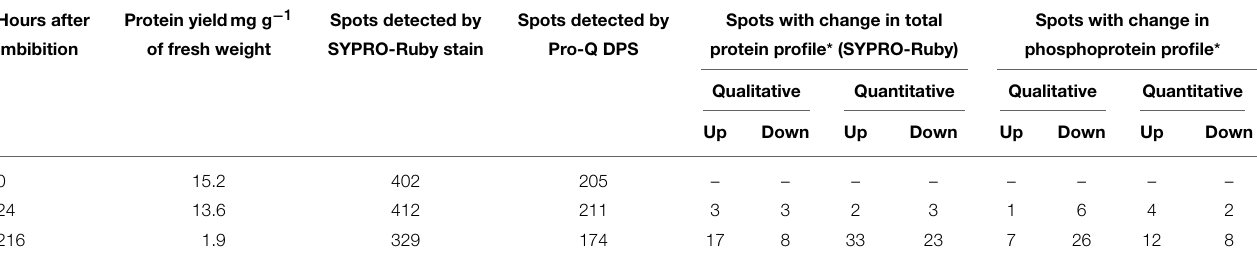
TABLE 1 | Electrophoretic analysis of changes in the protein and phosphoprotein profile during germination and seedling growth. Hours after Spots detected by Spots detected by Spots with change in total Spots with change in imbibition of fresh weight SYPRO-Ruby stain Pro-Q DPS protein profile * (SYPRO-Ruby) phosphoprotein profile * Qualitative Quantitative